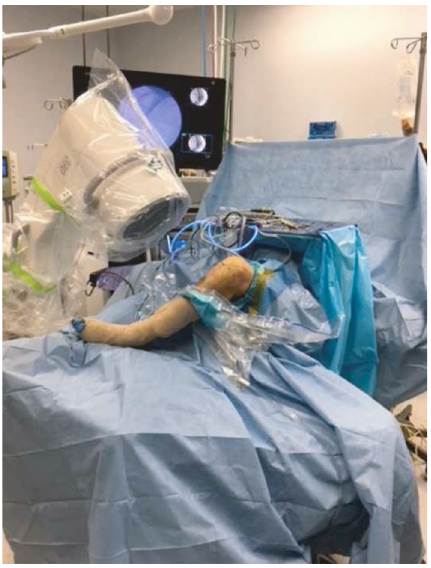
Figure 6: Intra-operative image of a C-arm positioned to obtain fl uoroscopic imaging of guide pin for the femoral tunnel to ensure intra-epiphyseal